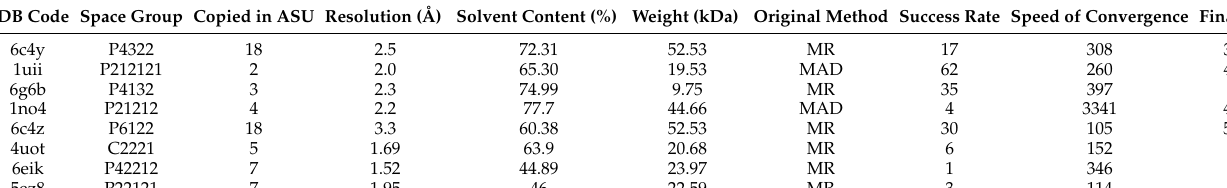
Table 1. Parameters of known protein structures.